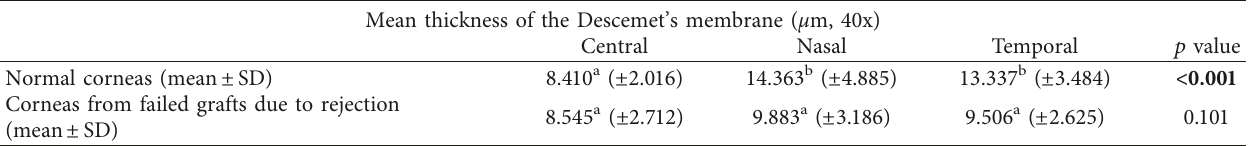
Table 2: Comparison of the mean thicknesses of the Descemet’s membrane obtained by digital microscopy in the different regions of normal corneas and corneas from failed grafts due to rejection.